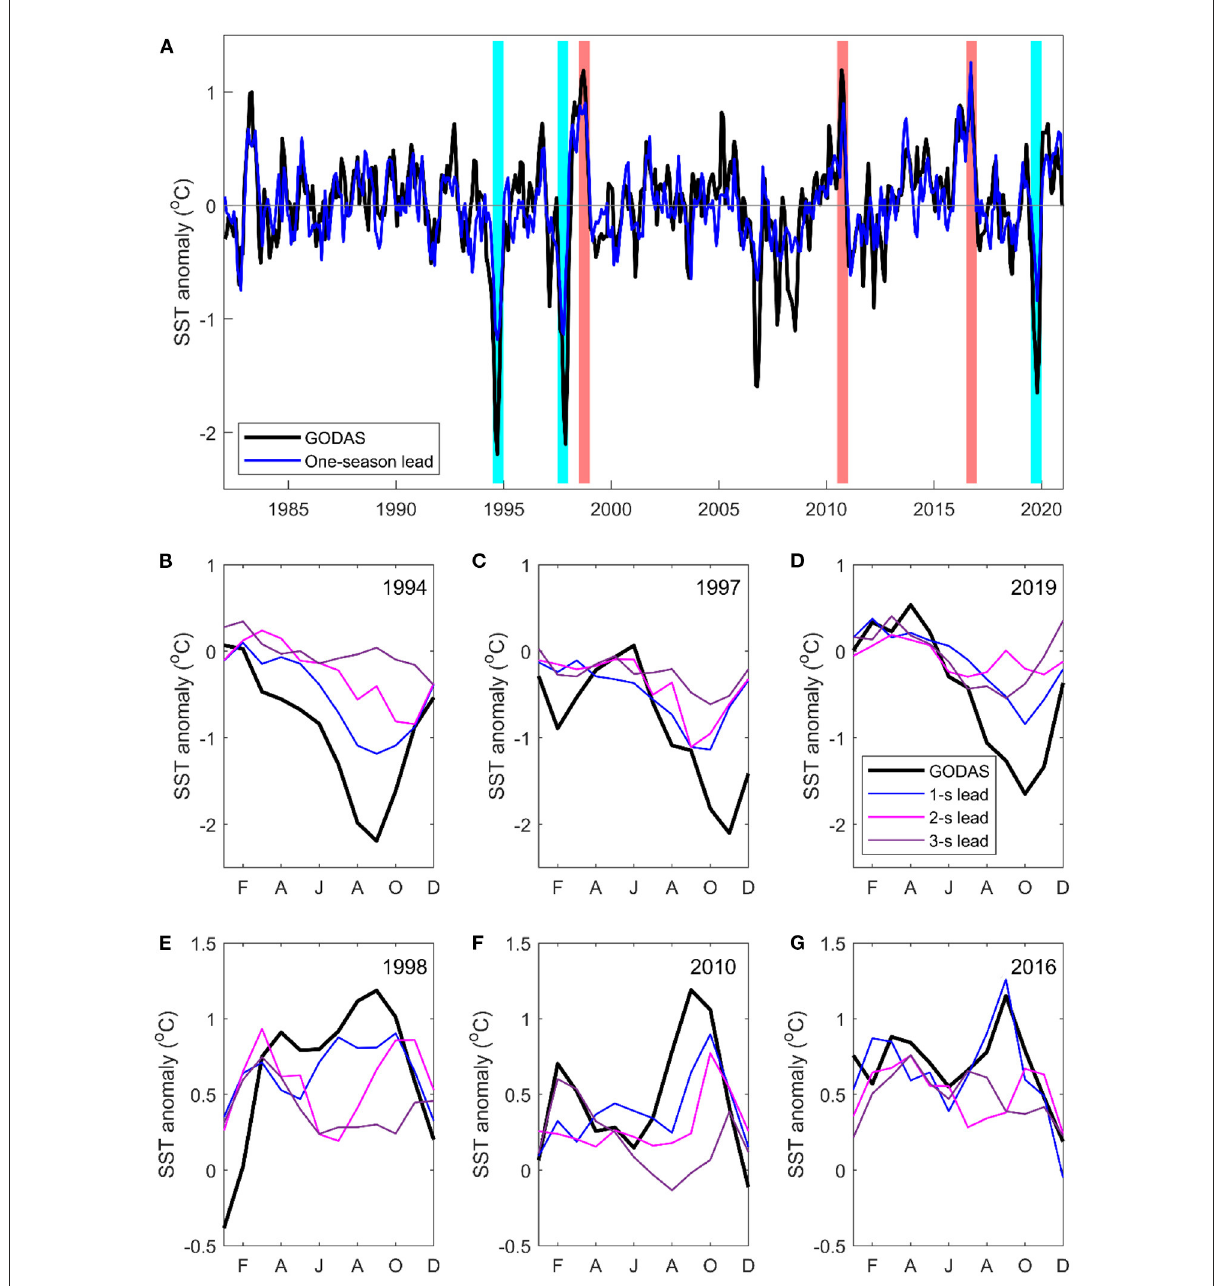
FIGURE3 (A) Comparing the GODAS SST anomalies in the EIOD region with the 2-month lead predictions from the CNN model during 1982–2020. (B–G) The comparison between GODAS SST anomalies and the 2, 5, and 8-month lead (or 1, 2, and 3-season lead) CNN model predictions during three strong positive IOD events (negative SST anomalies) and three strong negative IOD events [cyan and light red color shadings in (A) ]. The predictions are scaled by the standard deviations between GODAS SST anomalies and the zero-month lead CNN model prediction (a factor of